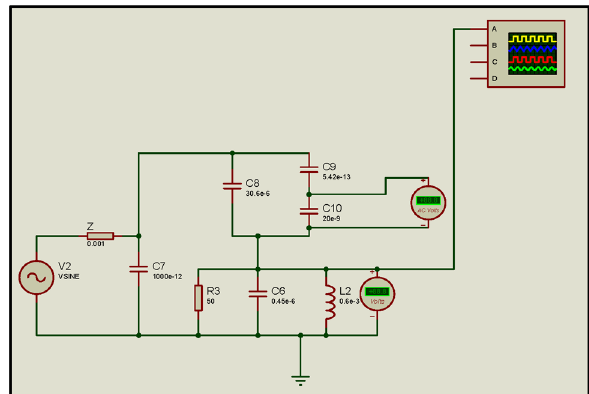
Figure 8: PD measurement